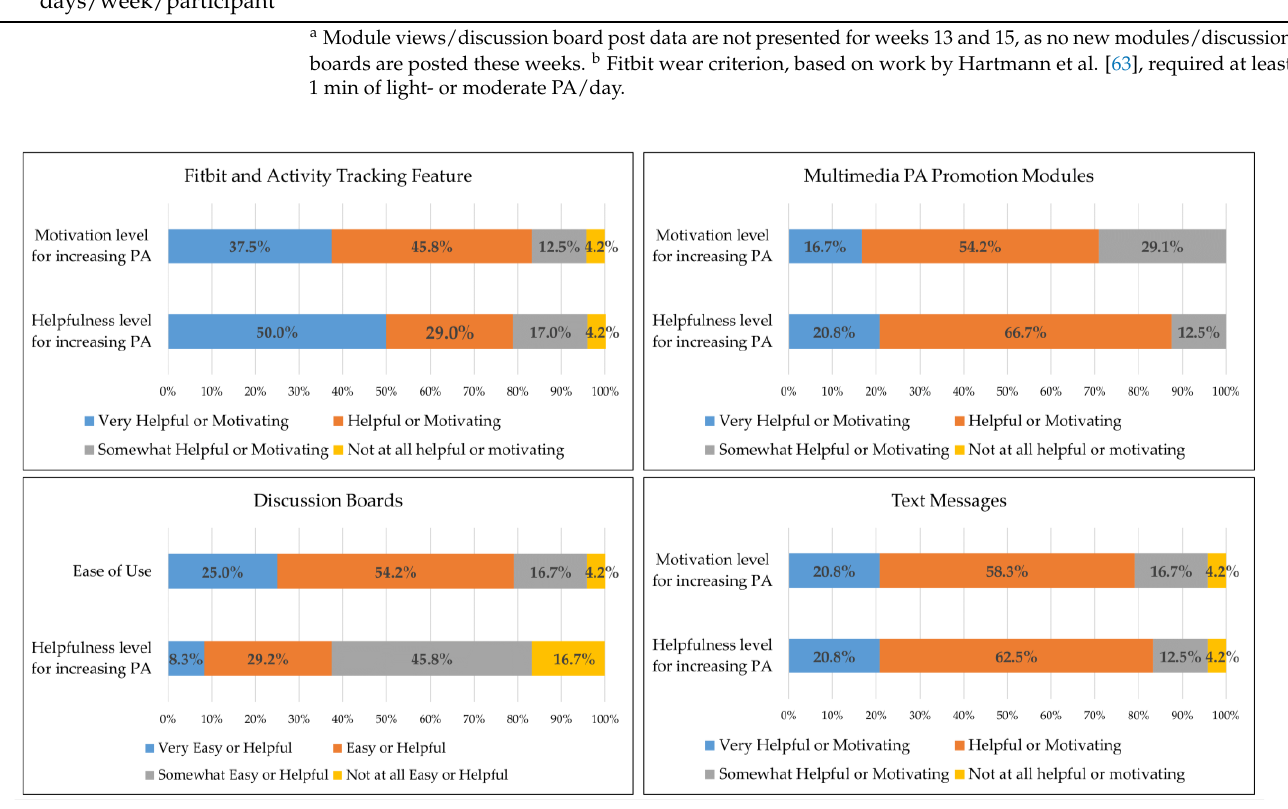
Figure 2. Participant-reported satisfaction with Smart Walk intervention components. Sums equalling greater than 100% are associated with rounding to the nearest tenth decimal